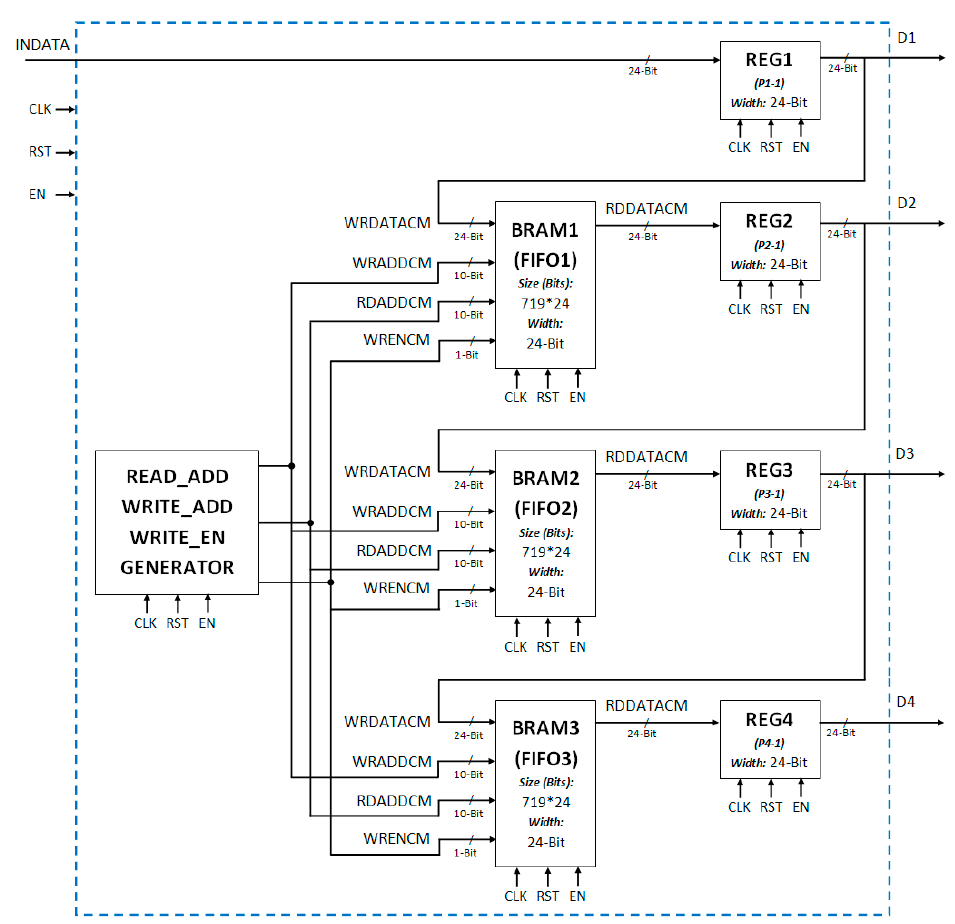
Figure 9. Detailed implementation of input buffer memory architecture using block RAMs and